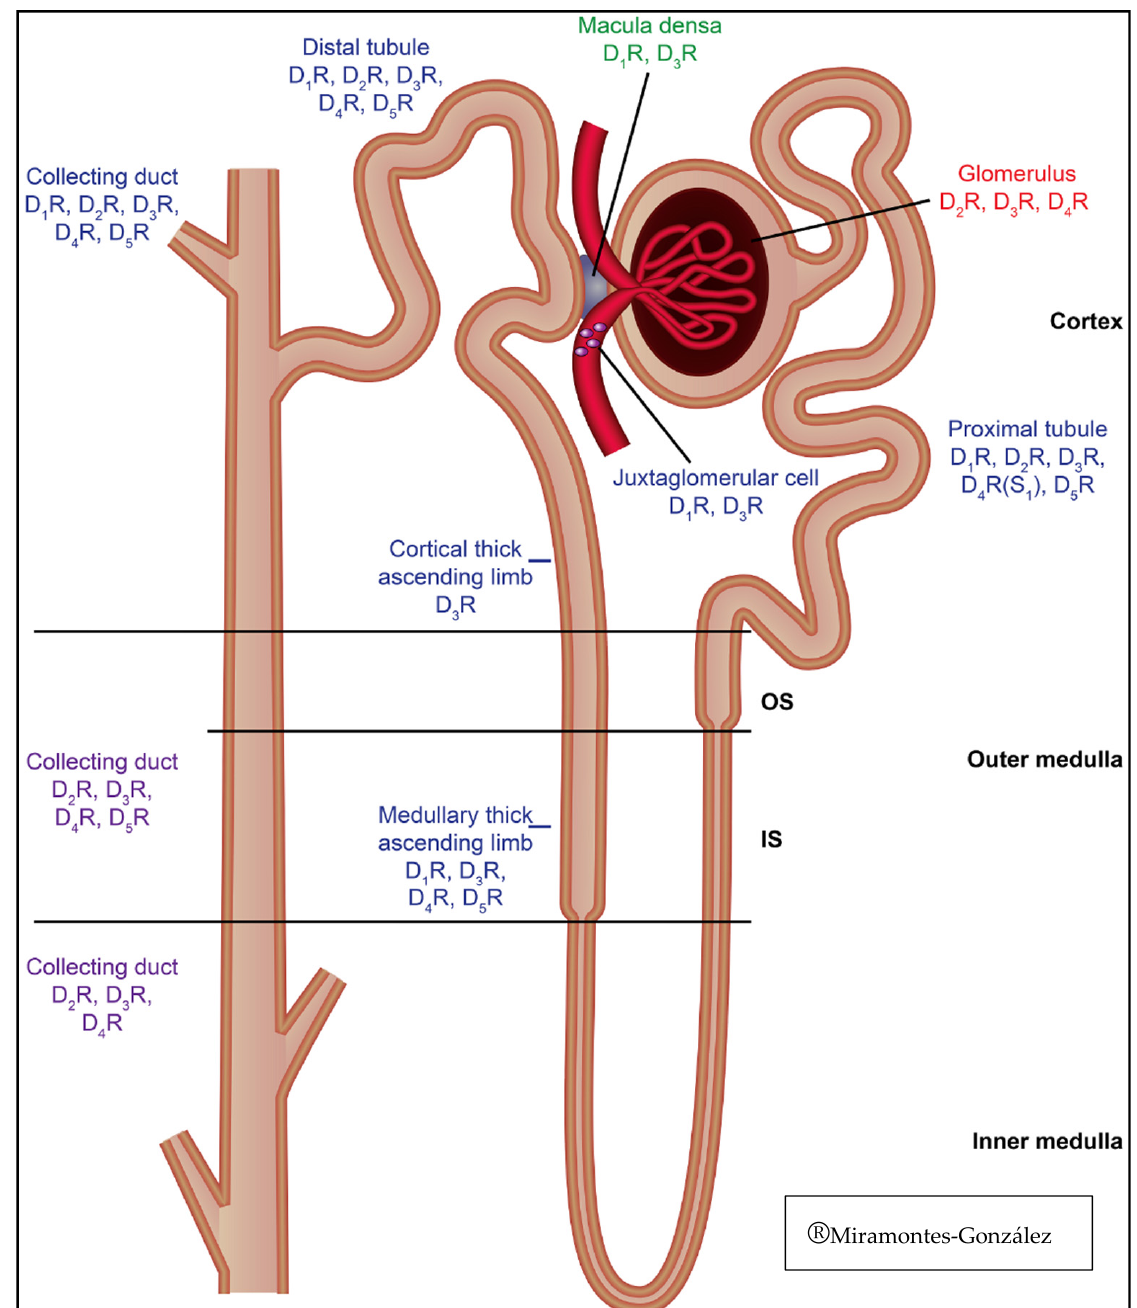
Figure 1. Distribution of dopamine receptors in the nephron.